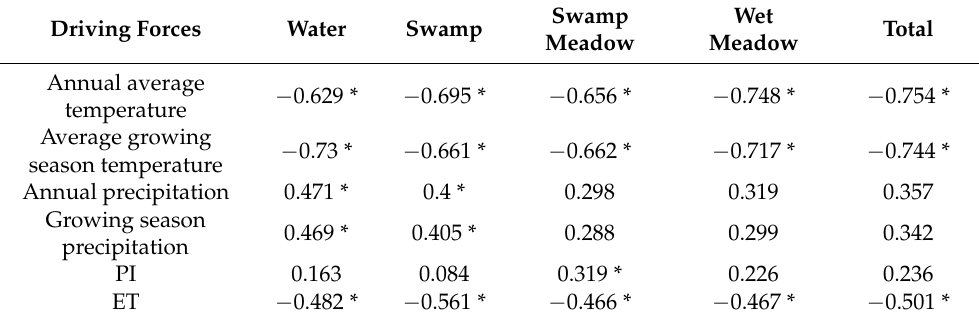
Swamp Wet Total Meadow Meadow